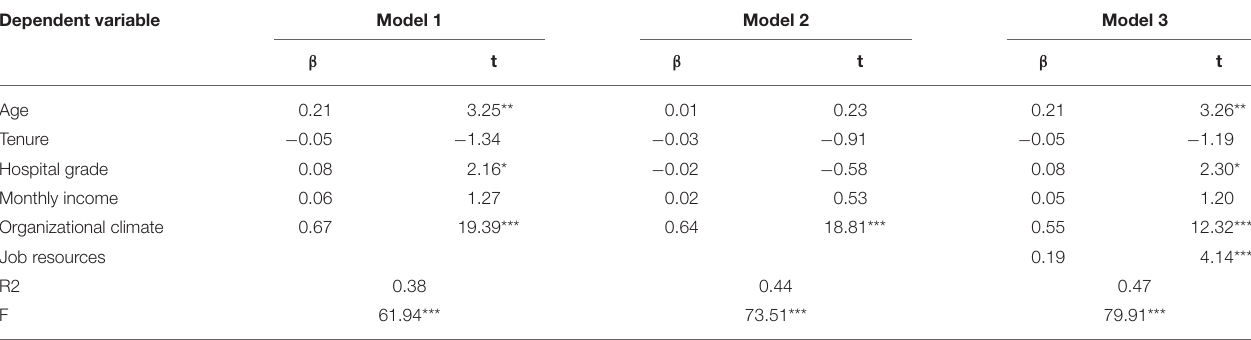
TABLE 2A | Mediation effects of job resources on the relationship between organizational climate and nurse engagement.